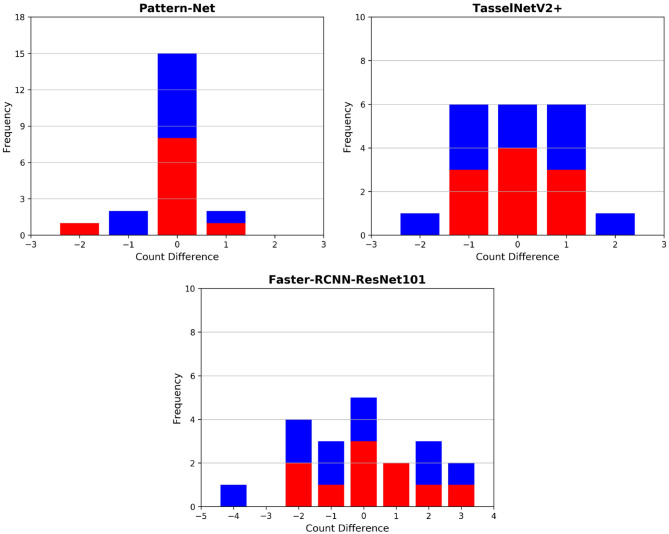
Histogram of count errors between the ears predicted by our 3D-based pipeline and 2D image-based approaches and the corresponding physical ground-truth measurements collected post-harvest; the image-based techniques include TasselNetV2+ (Lu and Cao, 2020) and Faster RCNN. The results of the individuals grown under well-watered and drought conditions are shown in red and in blue, respectively. 3D models with 2,048 points were used here. 2D images with 1,280 × 720 px were used for the image-based techniques.